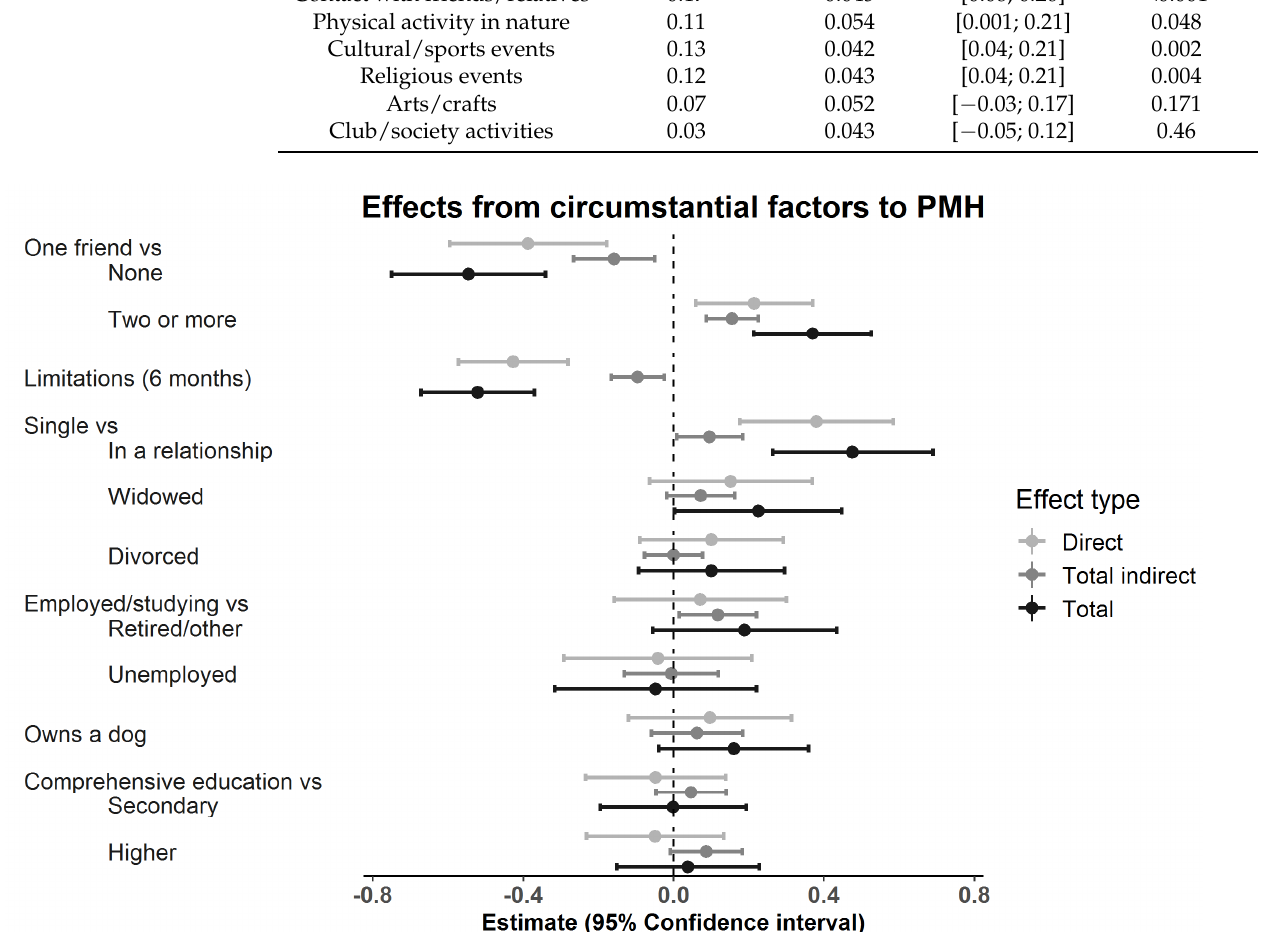
Figure 3. Direct, total indirect and total standardised effects from the circumstantial factors to positive mental health in the main model ( n = 801).